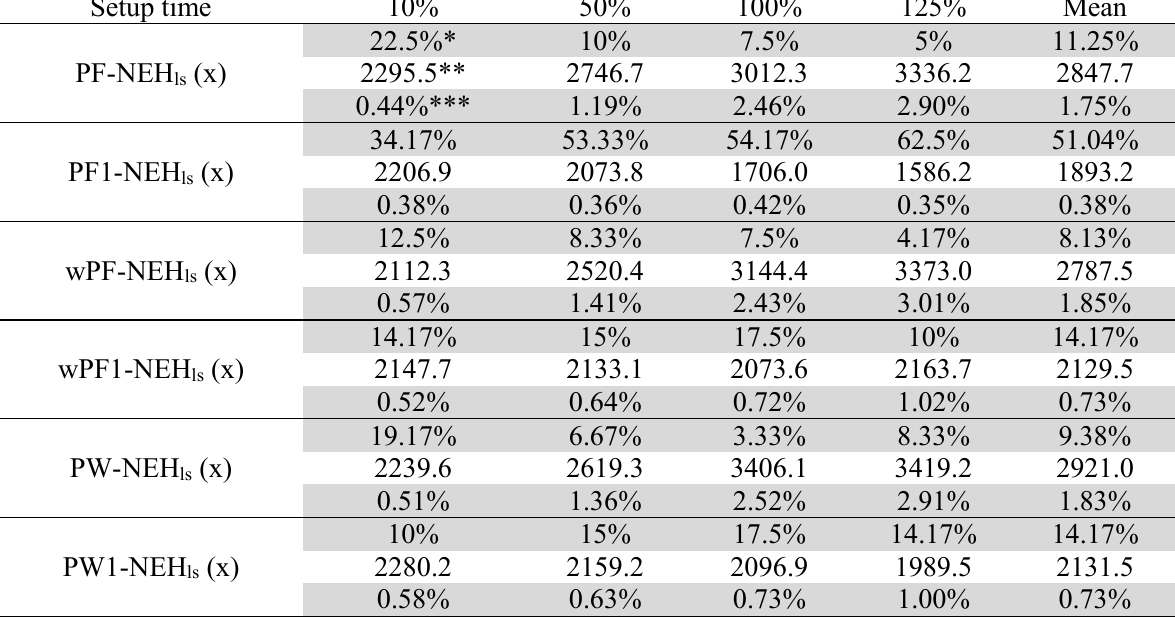
Fig. 3. MRD of the makespan of the phase II heuristics Performance of phase III